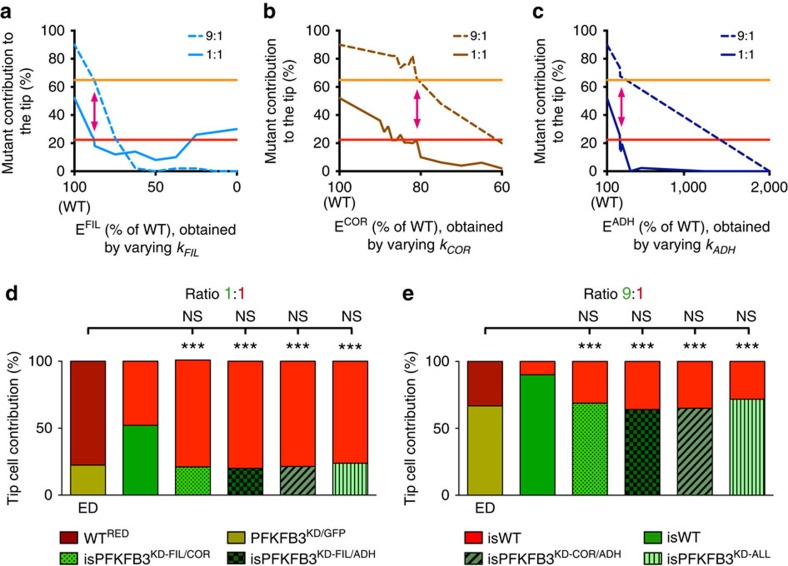
Effector mechanism simulations of tip cell contribution.(a–c) Sensitivity analyses of respectively EFIL (a), ECOR (b) and EADH (c) as single mechanism governing tip cell competition, by varying over a wide range values of respectively kFIL, kCOR and kADH. The results for both the 1:1 (full line) and 9:1 (dashed line) in silico PFKFB3KD:WT (isPFKFB3KD:isWT) mosaic sprouts are shown. The red and orange horizontal line depict the tip cell contribution of PFKFB3KD cells, as obtained experimentally in respectively the 1:1 and 9:1 PFKFB3KD:WT sprouts5. The combined 1:1 and 9:1 simulation results yielded one specific k value (see pink double-headed arrow) for every single effector mechanism. (d,e) Combinatorial EFIL/COR, EFIL/ADH, ECOR/ADH and EALL simulations of tip cell contribution in 1:1 (d) or 9:1 (e) isPFKFB3KD:isWT mosaic sprouts, illustrating that for every combinatorial effector, k values for its contributing effectors could be obtained matching the competitive disadvantage for PFKFB3KD cells as observed in the experimental PFKFB3KD:WT EC spheroid competition data (experimental data (ED), n=30 spheroids from 3 donors). For each combinatorial effector, the same k values matched both the 1:1 (first bar in d) and 9:1 (first bar in e) experimental mosaic PFKFB3KD:WT sprout data. The second bar in panel d and e shows the expected 50% (d) or 90% (e) contribution of isWT cells in 1:1 (d) or 9:1 (e) isWT:isWT sprouts. n=150; ***P<0.001, versus isWT:isWT. ‘NS' (not significant) versus ED; Fisher's exact test.